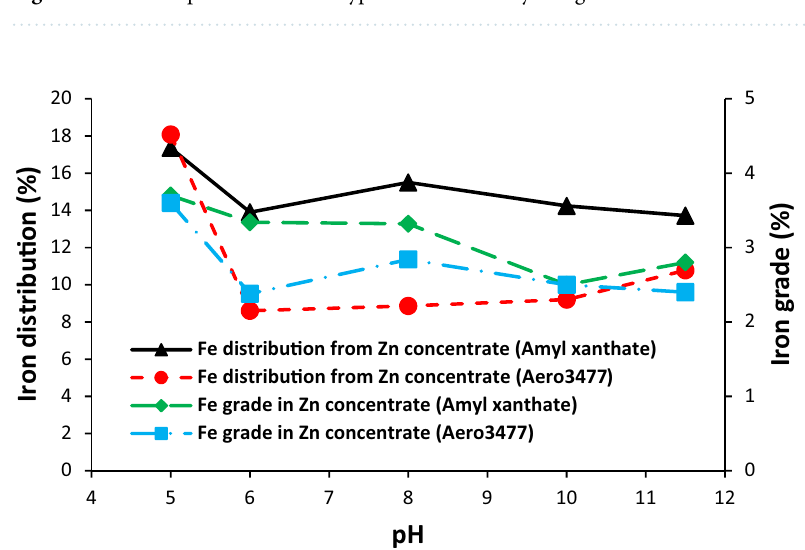
Figure 9. Effect of pH and collector type on the iron distribution and grade in the zinc